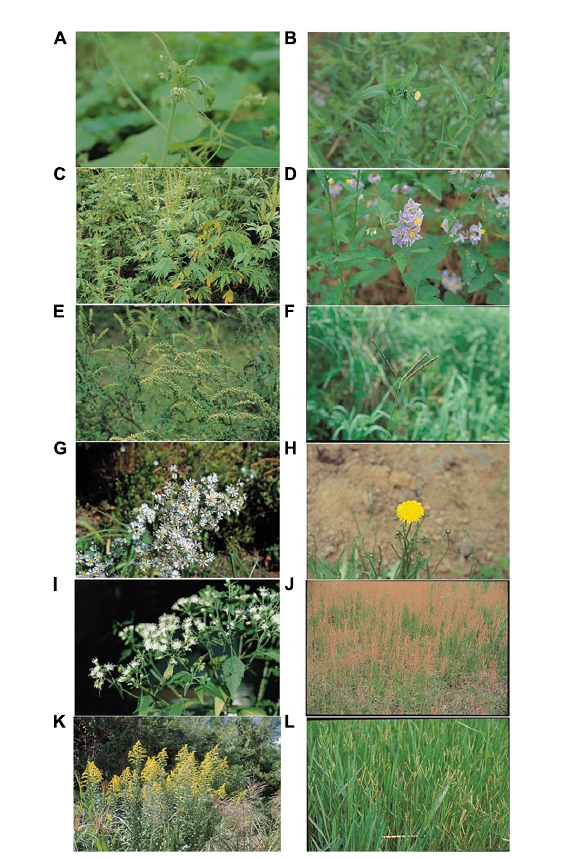
FIGURE1 Photographs of EDAPS used in this study. (A) Sicyos angulatus , (B) Lactuca serriola , (C) Ambrosia trifida , (D) Solanum carolinense , (E) Ambrosia artemisiifolia , (F) Paspalum distichum , (G) Symphyotrichum pilosum , (H) Hypochaeris radicata